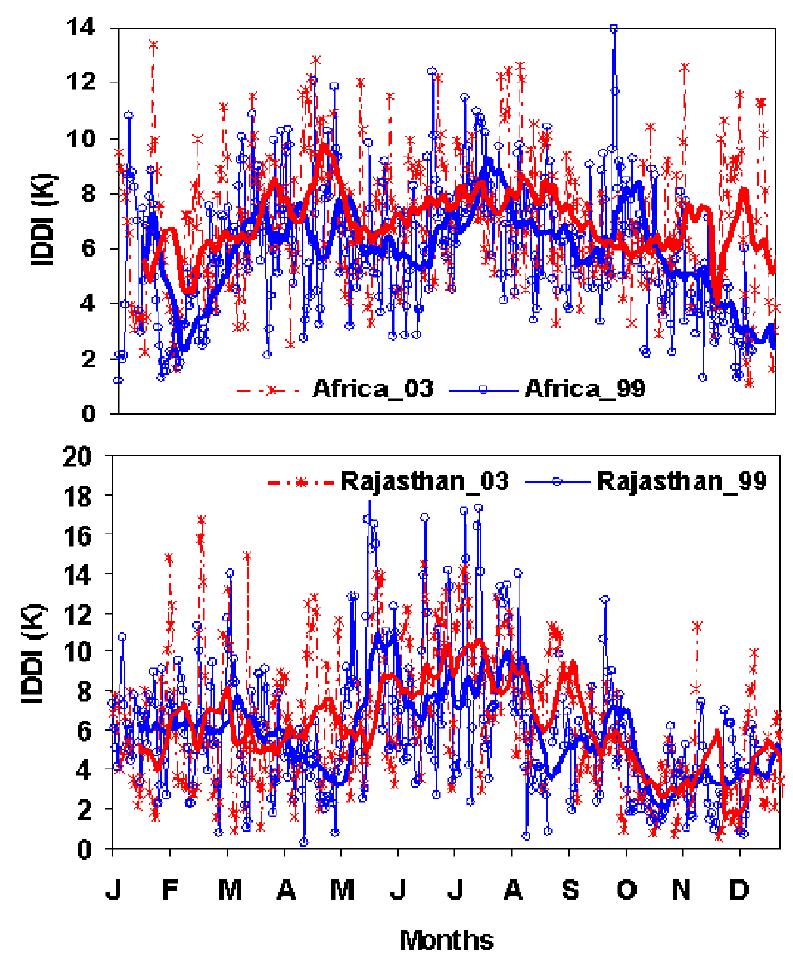
Fig. 21. Temporal variation of IDDI (K) (dashed lines) for 1999 (blue) and 2003 (red) over northeast Africa and Rajasthan. The solid lines represent a 15-day running